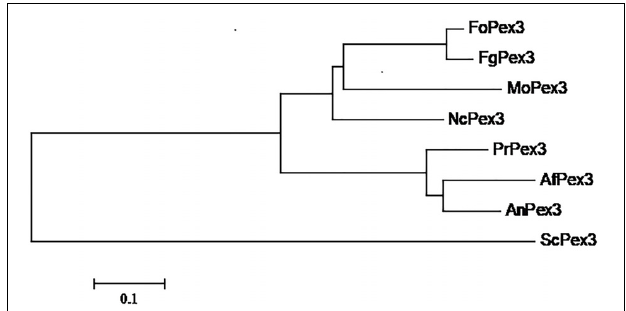
FIGURE 1 | Phylogenetic relationship of Pex3 protein homologs. Phylogenetic relationship of Pex3 homologs calculated using the neighbor-joining method with the MEGA 6.0 program. Abbreviations and accession numbers of the sequences are as follows: FoPex3 (EWZ44752.1) from Fusarium oxysporum Fo47; FgPex3 (XP_011326612.1) from Fusarium graminearum PH-1; MoPex3 (XP_003717143.1) from Magnaporthe oryzae 70–15; NcPex3 (XP_962987.1) from Neurospora crassa OR74A; PrPex3 (XP_002567187.1) from Penicillium rubens Wisconsin 54–1255; AfPex3 (XP_002383001.1) from Aspergillus flavus NRRL3357; AnPex3 (XP_659885.1) from Aspergillus nidulans FGSC A4; ScPex3 (NP_010616.3) from Saccharomyces cerevisiae